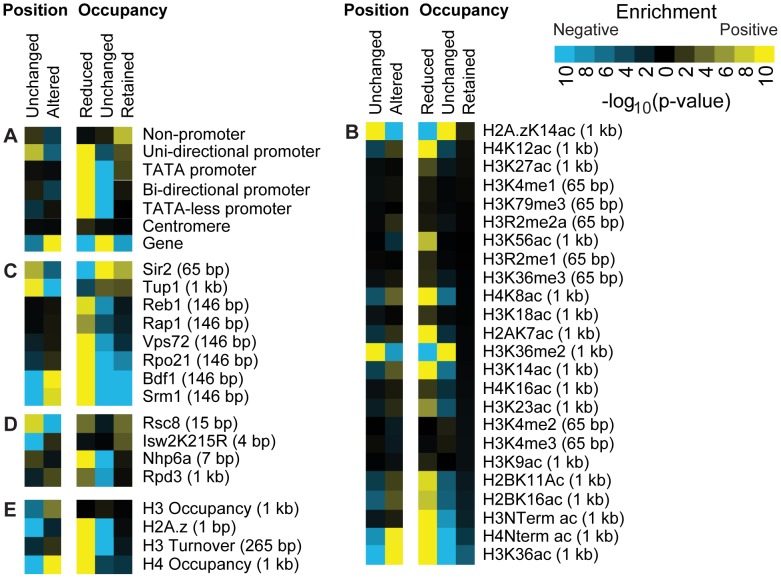
Histone acetylation is associated with reduced nucleosome occupancy.The positive (yellow) or negative (blue) association of previously published genome-wide data sets and genome annotations with nucleosome change categories (Materials and Methods). (A) Genome annotations, (B) histone modifications, (C) transcription-associated proteins, (D) chromatin remodelers and (E) histone occupancy. The number in parenthesis indicates the resolution of the detection platform in the data set used for comparison.